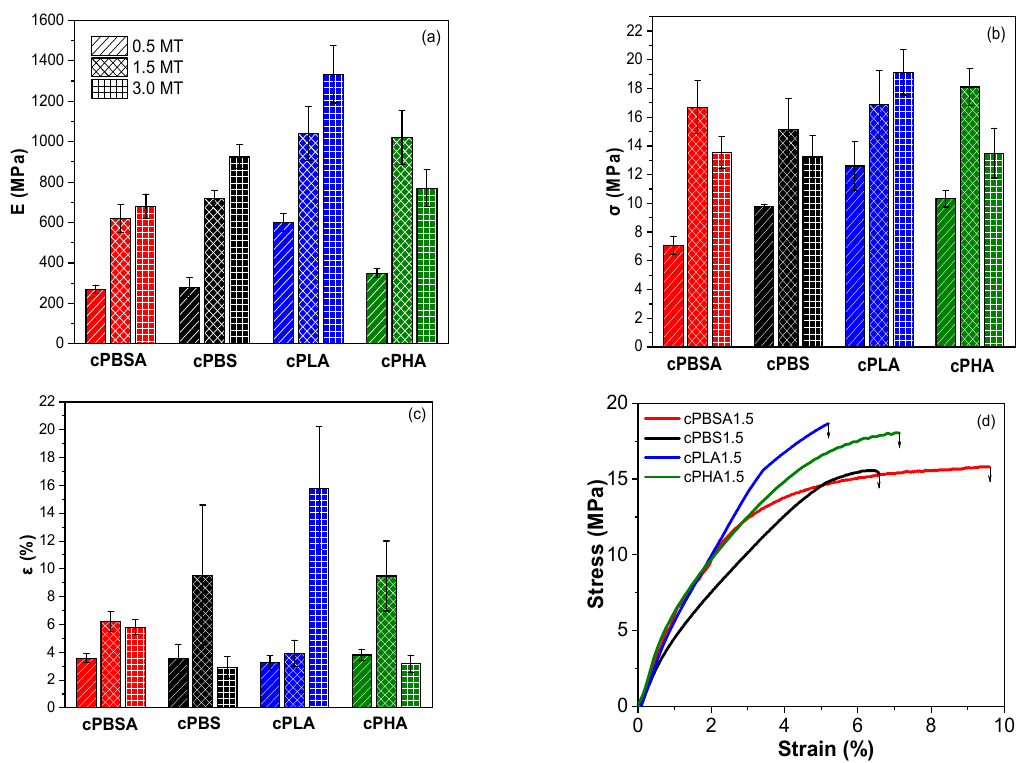
Figure 5. ( a ) Elastic modulus, ( b ) tensile strength, ( c ) elongation at break, and ( d ) representative stress–strain curves for laminates prepared with 1.5 MT pressure.